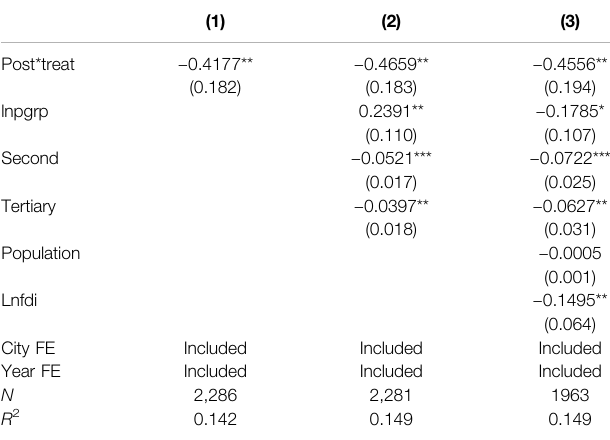
TABLE 4 | The results of the impact of low carbon city pilot on energy